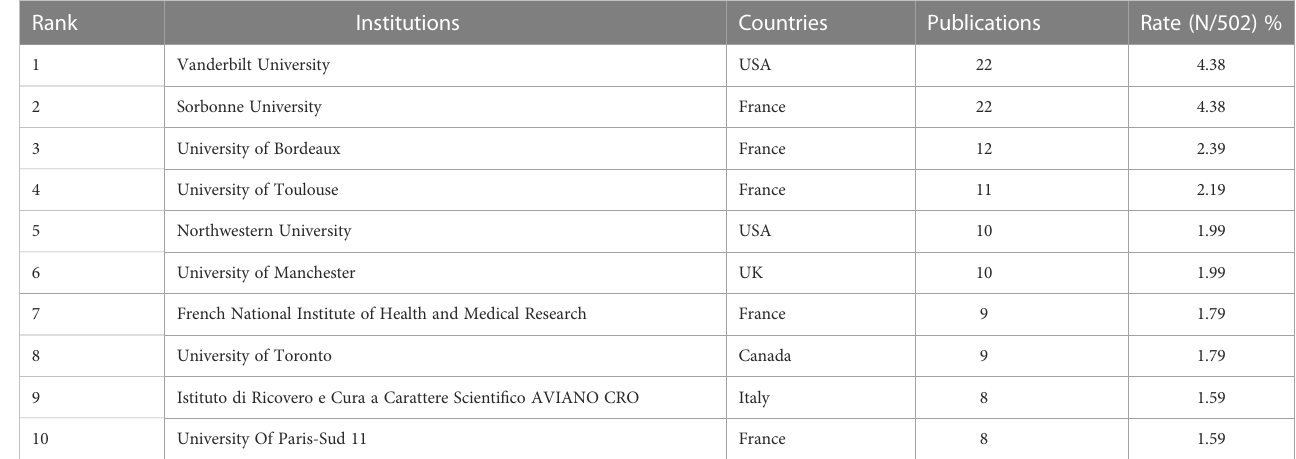
TABLE 2 Top 10 institutions with a high volume of publications in pharmacovigilance and cancer research. Rank Institutions Countries Publications Rate (N/502)